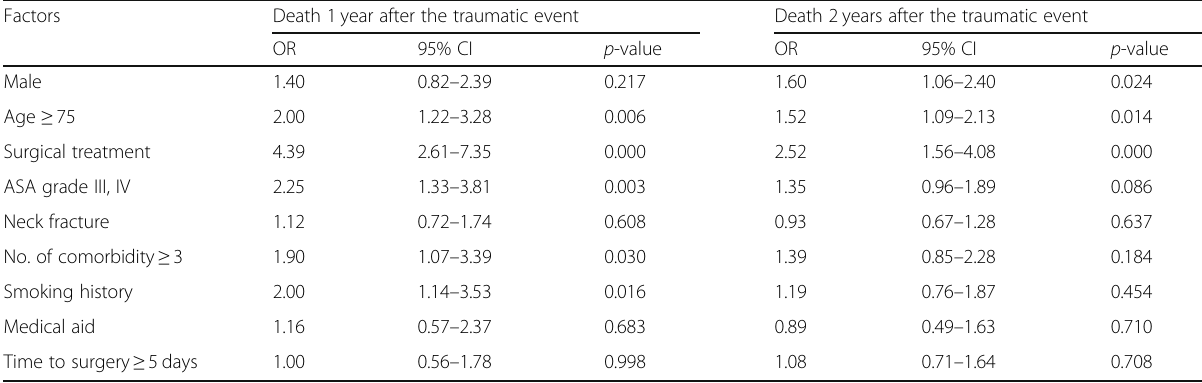
Table 5 Predictors of mortalities 1 and 2 years after the traumatic events